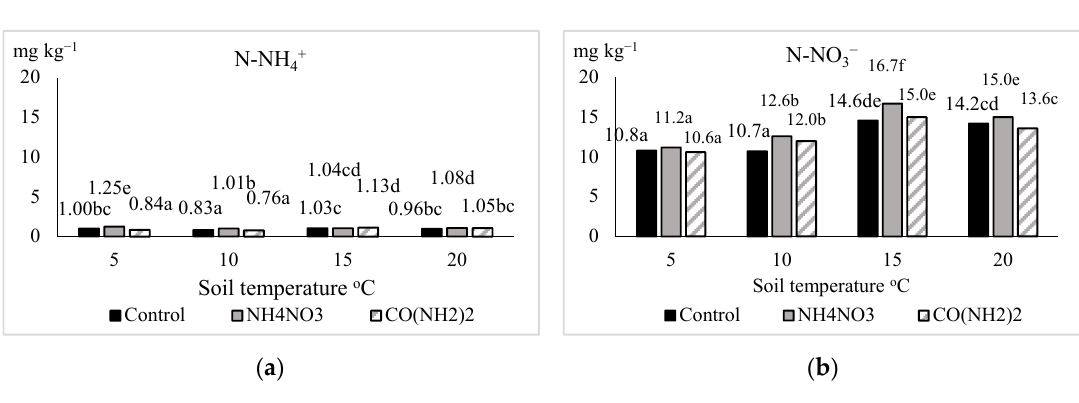
Figure 4. The influence of nitrogen fertilizers and ambient temperature on the changes of ( a ) N-NH 4+ and ( b ) N-NO 3 − nitrogen in the 15–30 cm soil layer with a simulated precipitation of 20 mm. Values followed by different letters are significantly different ( p ≤ 0.05) based on Fisher’s LSD test.